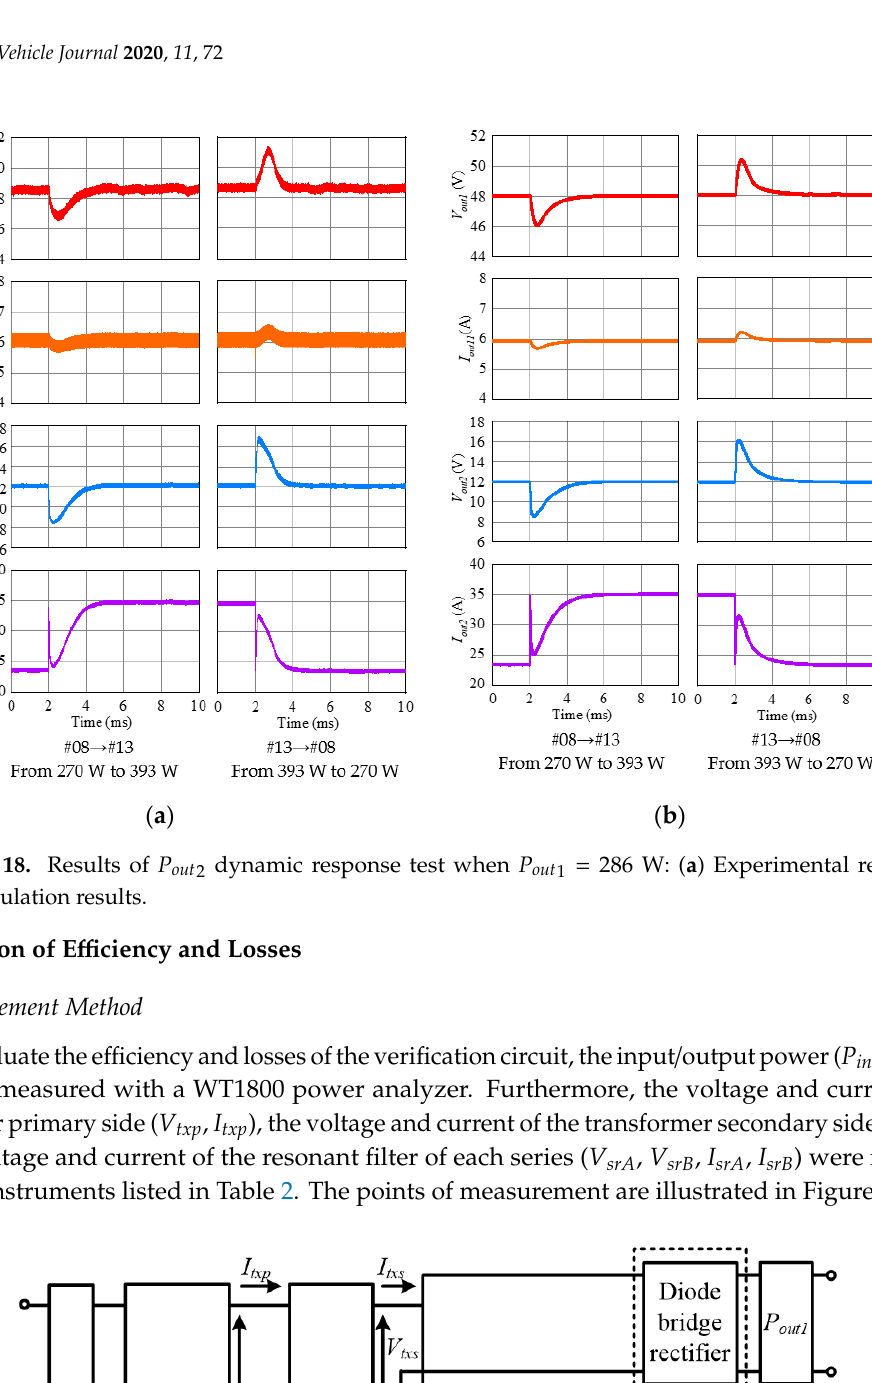
Figure 17. Results of P out 1 dynamic response test when P out 2 = 140 W: ( a ) Experimental results; ( b ) Simulation results.